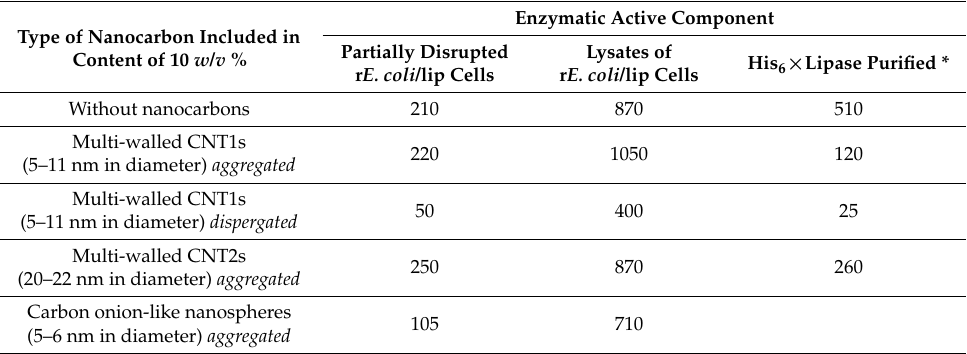
Table 4. Hydrolytic activities (in U · g − 1 ) of prepared lipase-active biocatalysts depending on the origin of enzymatic active component and nanocarbons included inside silica xerogel.